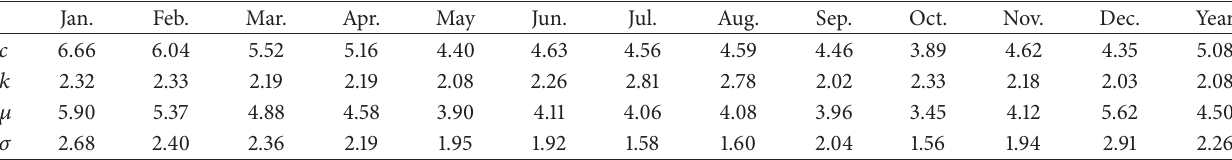
Table 4: 2008 monthly and yearly 10 m height statistical parameters.